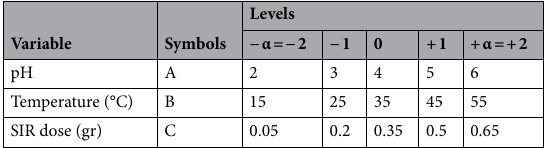
Table 1. Coded and actual levels of the independent parameters in CCD (α = axial points).